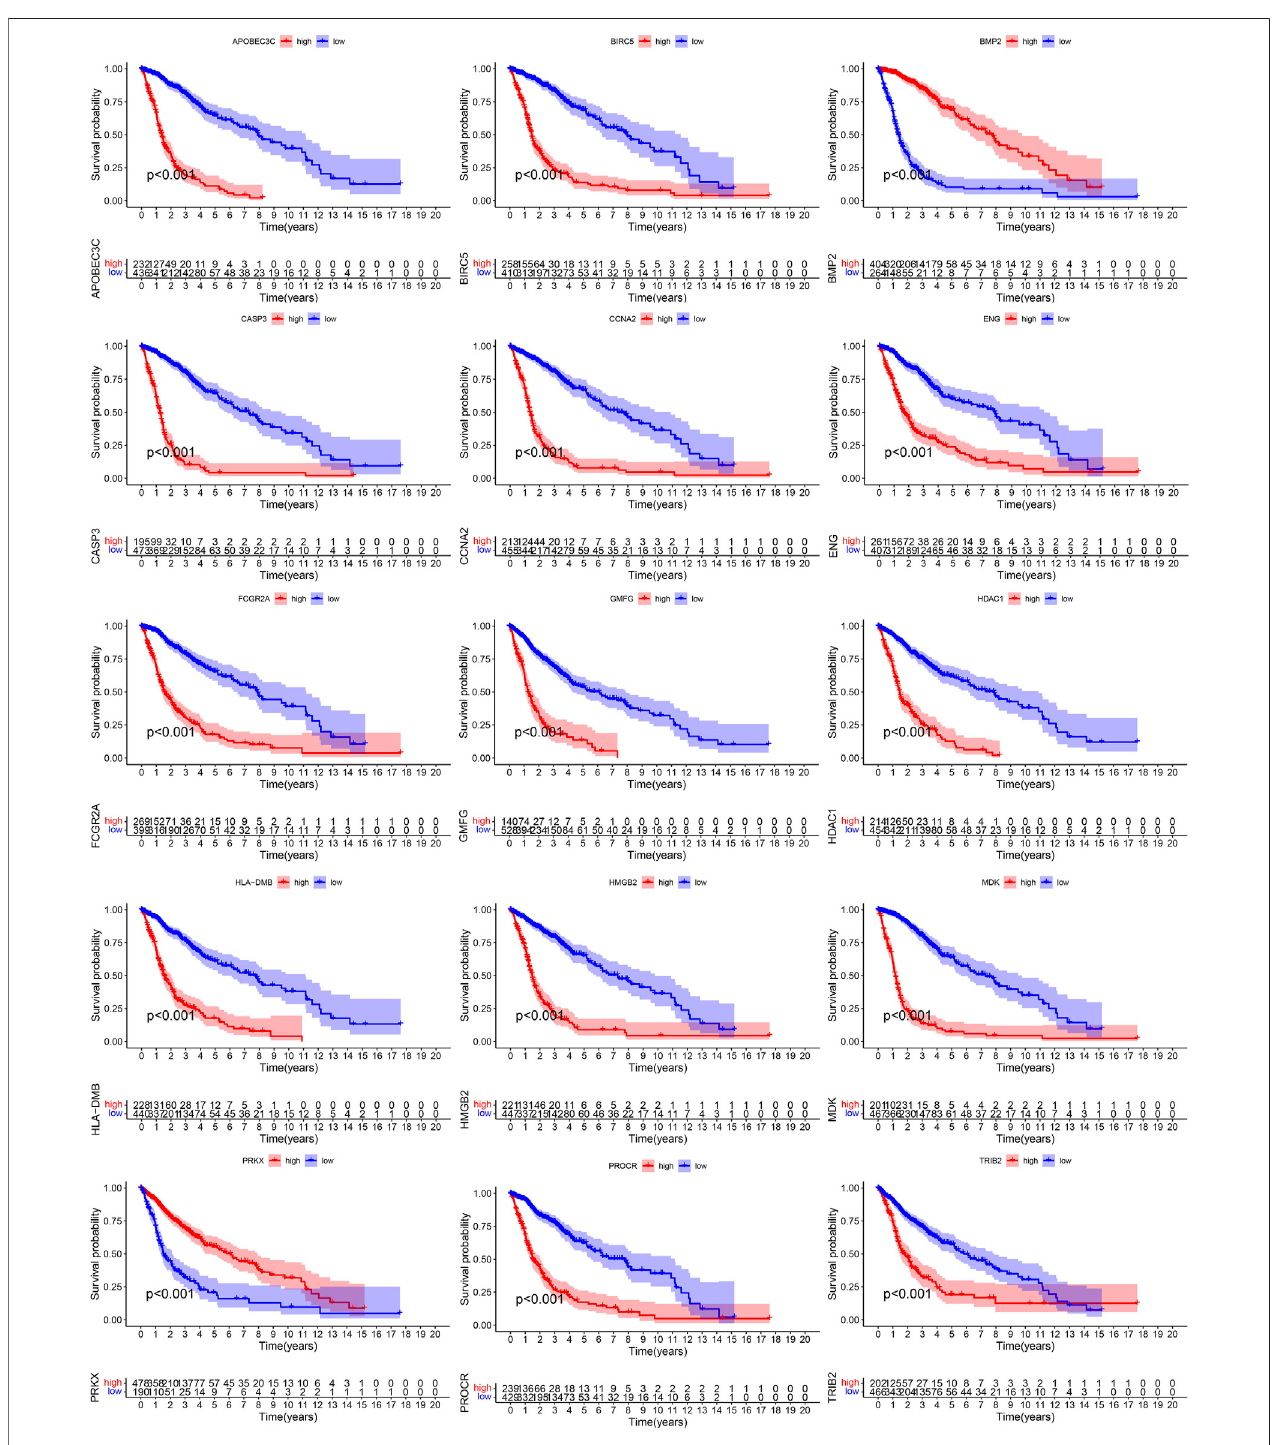
FIGURE 4 | Survival curves of 15 PR-DE-IRGs from TCGA